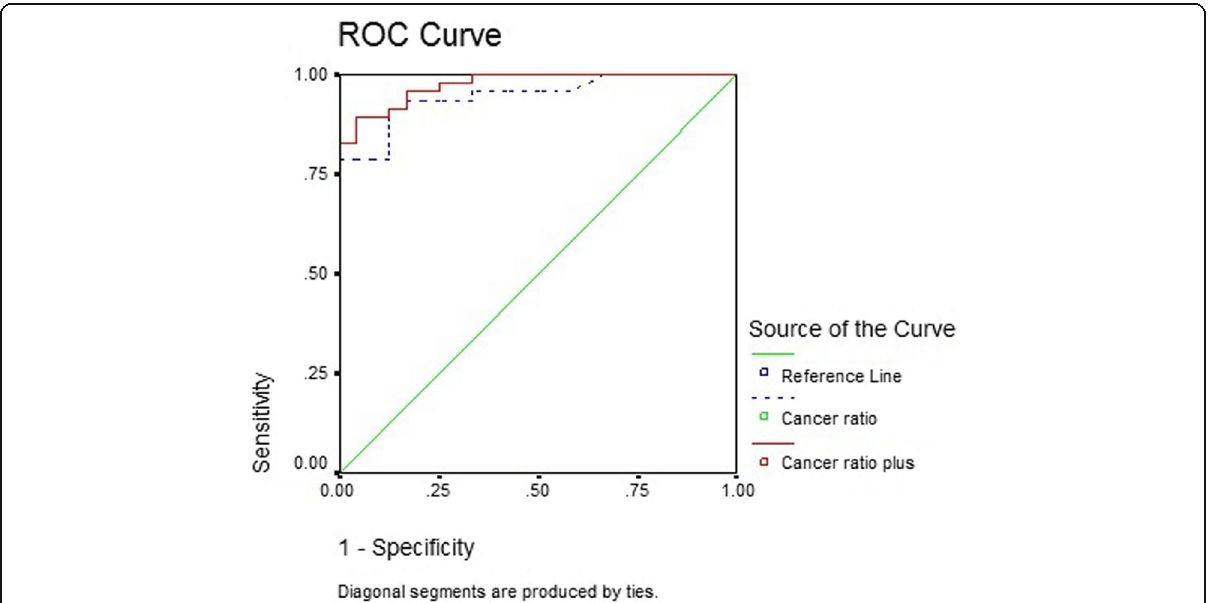
Fig. 1 The ROC curves of cancer ratio and cancer ratio plus for discriminating MPE than any other lymphocytic pleural